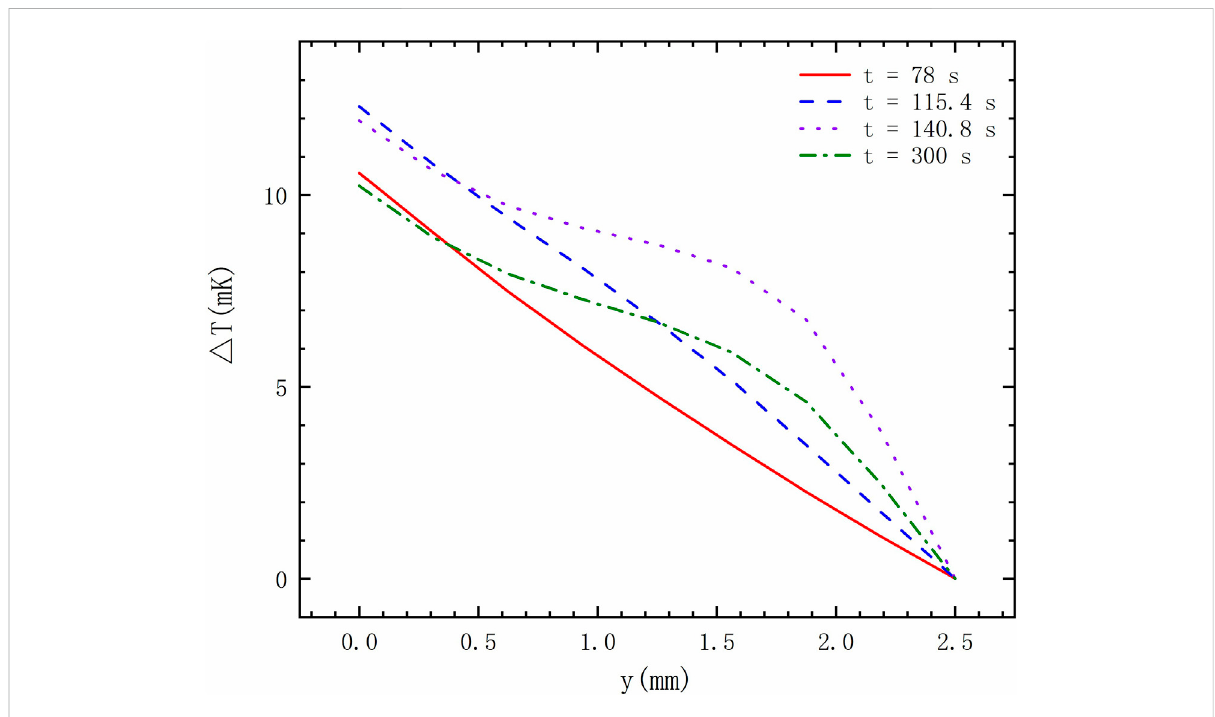
FIGURE 7 Temperature distributions along the line x = 5